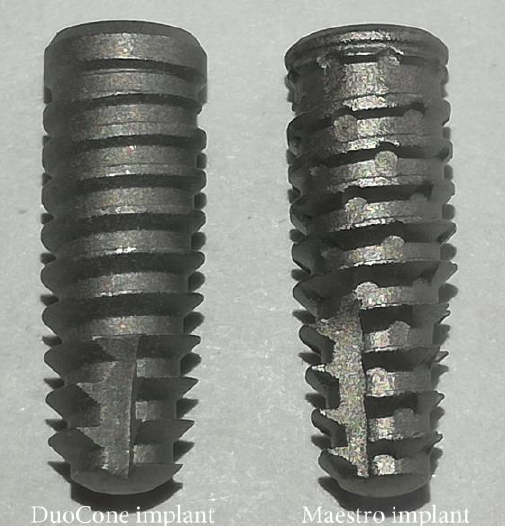
Figure 1. Representative image of both tapered implants with different macrogeometries used in the present study.